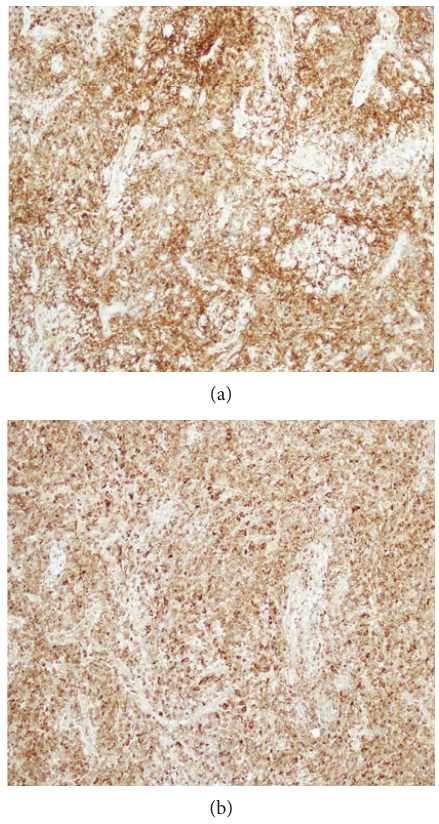
Figure 4: Neoplastic cells strongly express